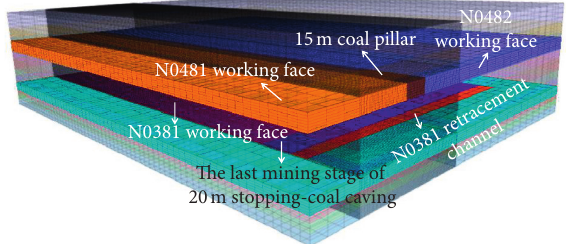
Figure 11: Global model (the upper coal pillar with the aspect ratio of